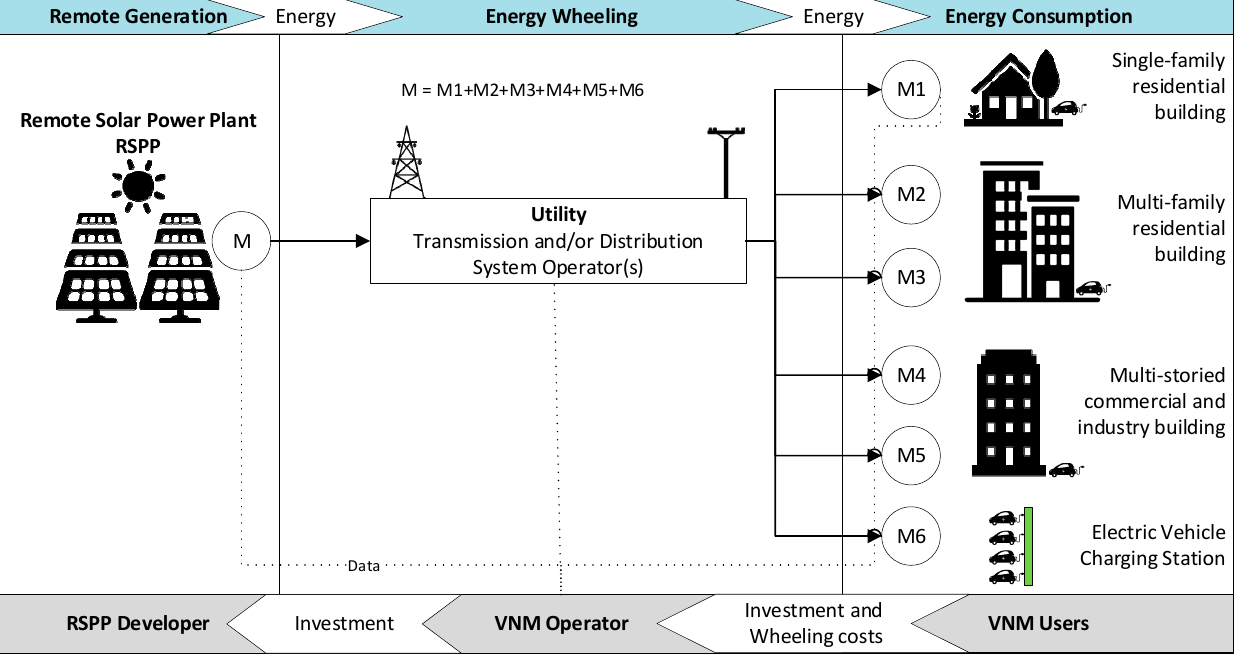
Table 1. Typologies of VNM, description, and potential users. Adapted from [20].